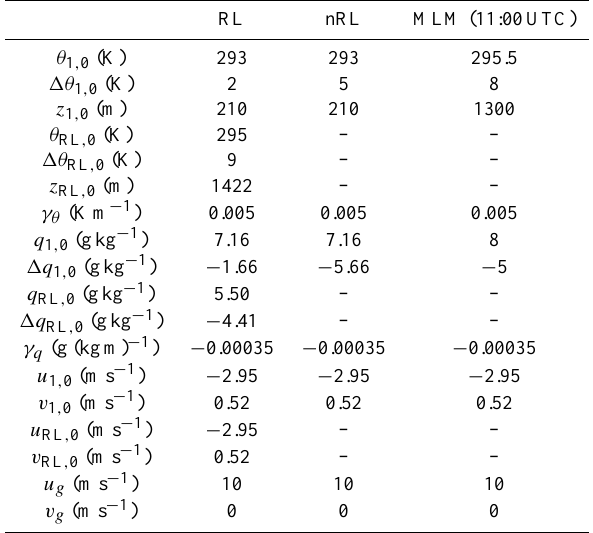
Table 1. Based on the observations taken at the BLLAST campaign on 1 July 2011, initial and prescribed values used for DALES (RL and nRL numerical experiments) and MLM of the boundary-layer depth, mixed-layer and residual layer values of the scalars ( θ 1 , 0 , θ RL , 0 and q 1 , 0 , q RL , 0 ), and their corresponding jump at the inver- sion ( 1θ 1 , 0 , 1θ RL , 0 , 1q 1 , 0 and 1q RL , 0 ). γ i is the FA lapse rate of each variable i . Initial ( u 1 , 0 , u RL , 0 , v 1 , 0 , v RL , 0 ) and geostrophic ( u 1 , 0 , u g , v g ) wind components are also indicated. Surface fluxes ( w 0 θ 0 | s and w 0 q 0 | s ) are prescribed as 0.1668 sin (π(t − 5 )/ 12 . 5 ) and 0.1032 sin (π(t − 5 . 5 )/ 13 . 5 ) respectively. Time t goes from